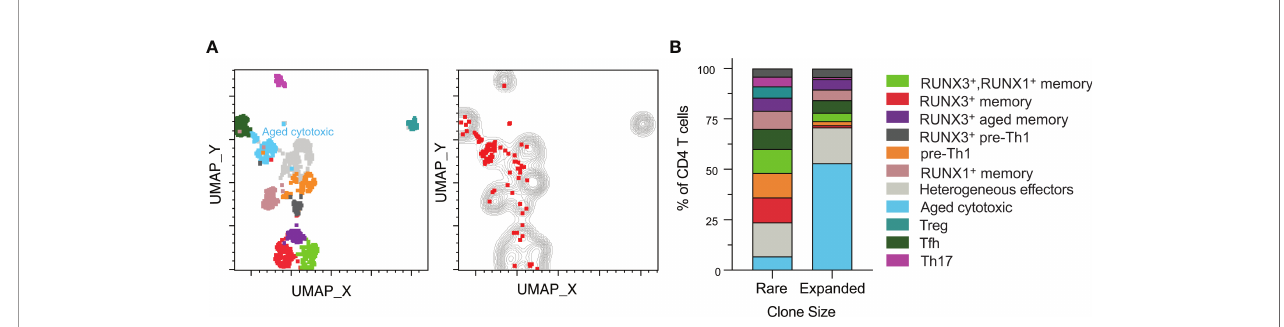
FIGURE 4 | Clonally expanded CD4 T cells have a distinct aged cytotoxic phenotype. CD4 + T cell data from all six subjects and time points were gated for TCR analysis. (A) , left UMAP plot from Figure 2 of all samples depicted with aged cytotoxic cluster labeled. (A) , right Rare clones are displayed as a gray contour plot. Red dots represent expanded clones as de fi ned by the presence of one cell of a clone at different time points or two or more cells at the same time point. All cells from all subjects are depicted in either the gray or the red. (B) Rare and expanded clones were organized into a stacked bar graph of cluster frequencies.